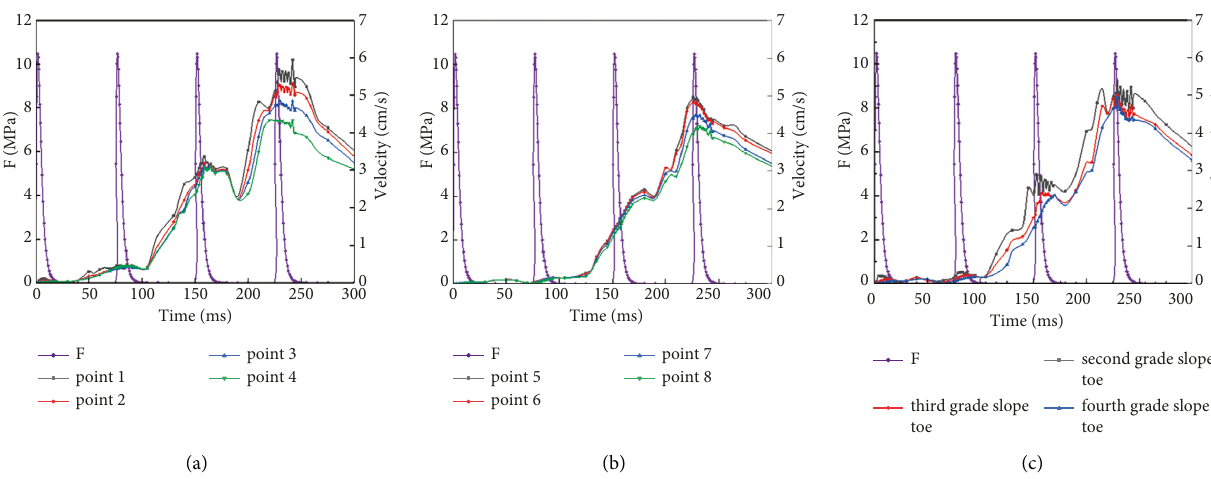
Figure 13: Time-history curves of vibration velocity at different measurement points at different positions and different times during millisecond blasting. (a) On the slope toe. (b) On the slope top. (c) On the slope